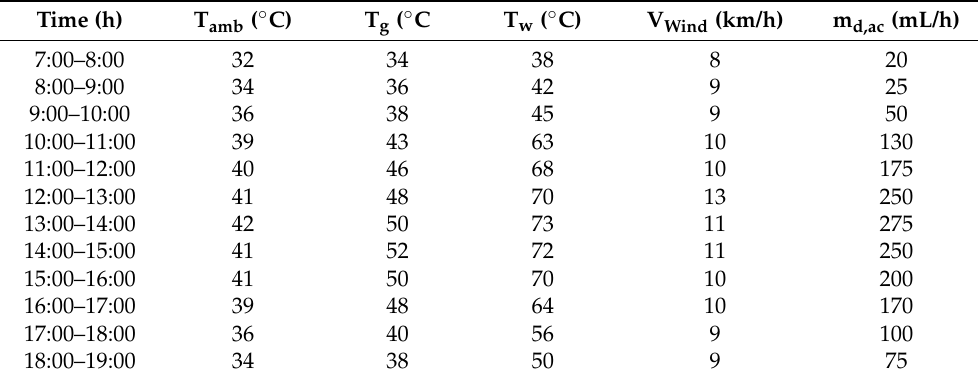
Table 2. Hourly data of variation in temperatures, wind speed, and productivity. Time (h) T amb ( ◦